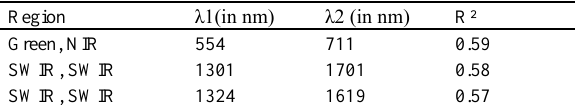
Table 5. Best band combinations using farmers' field data